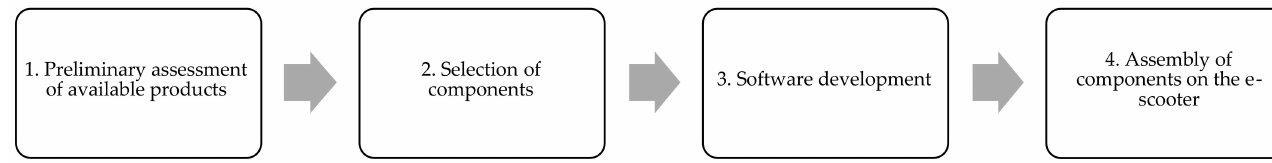
Figure 1. Stages for the e-scooter